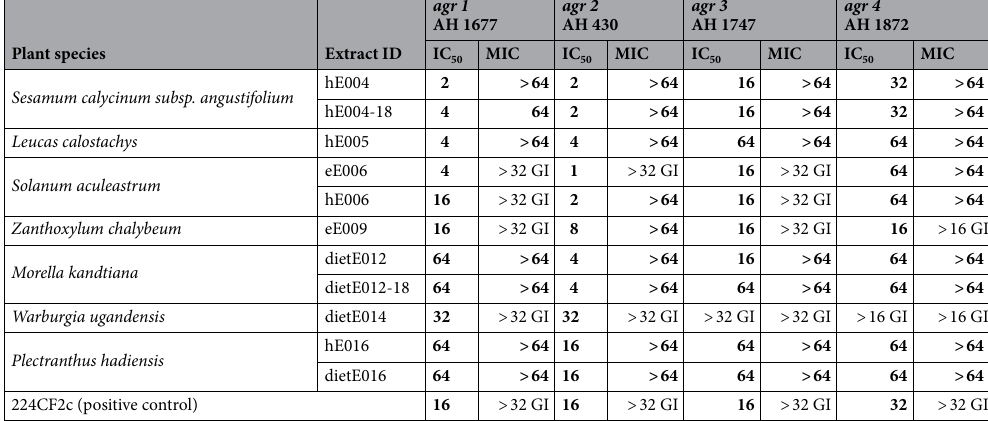
Table 3. Results of the quorum-sensing inhibition in vitro dose-response studies: IC 50 and MIC values. The calculated IC 50 and MIC values of plant extracts, represented in μg/mL, are displayed. The most active extracts were selected for confirmation of antivirulence activity via a δ-toxin production and quantification assay; > 16/32 GI describes undetectable IC 50 and MIC values due to growth inhibition at 16 or 32 μg/mL. GI, growth